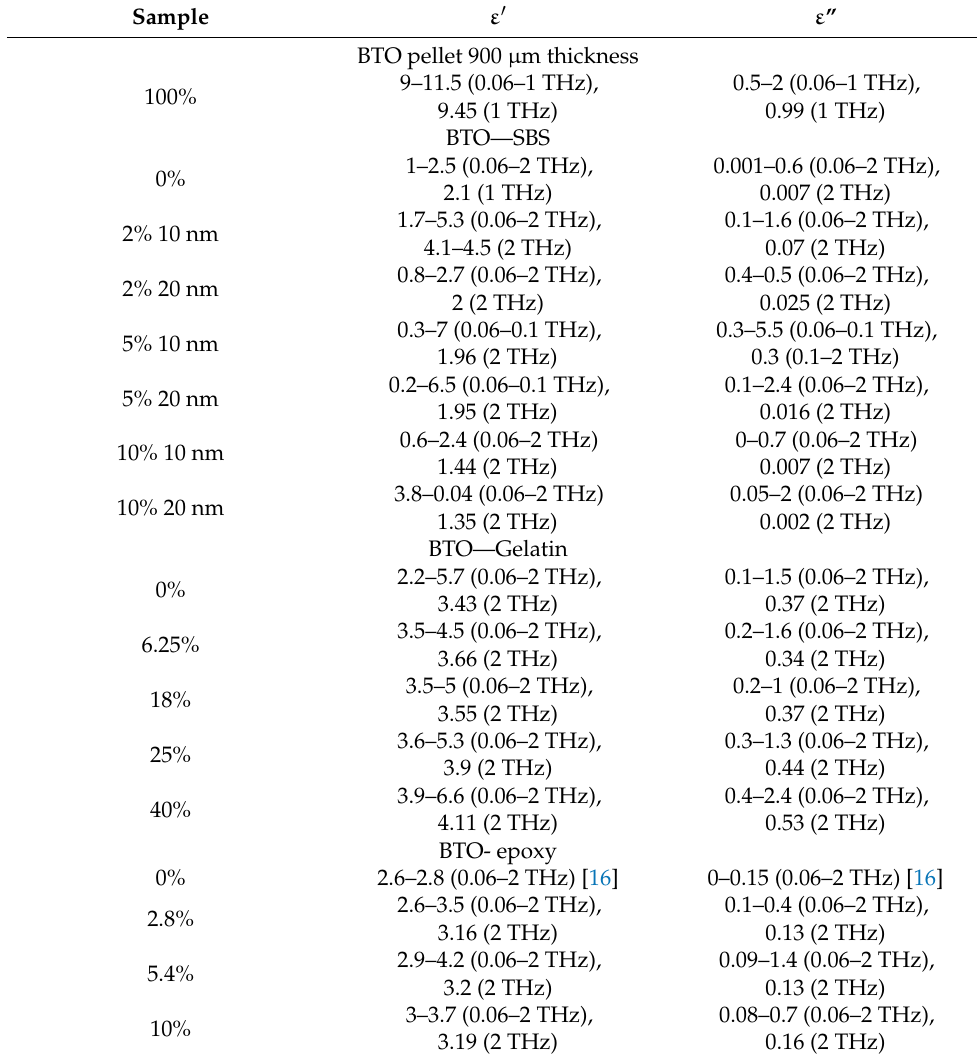
Table 1. Dielectric properties of different matrix-embedded BTO nanoparticles.